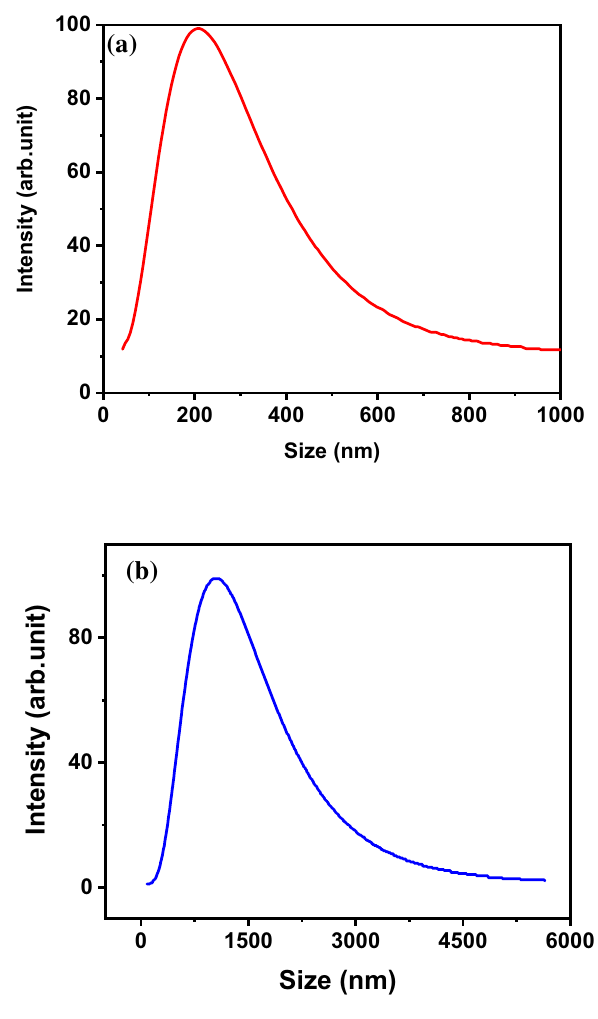
Fig. 2 Plot of particle size distribution a at low angle scattering,